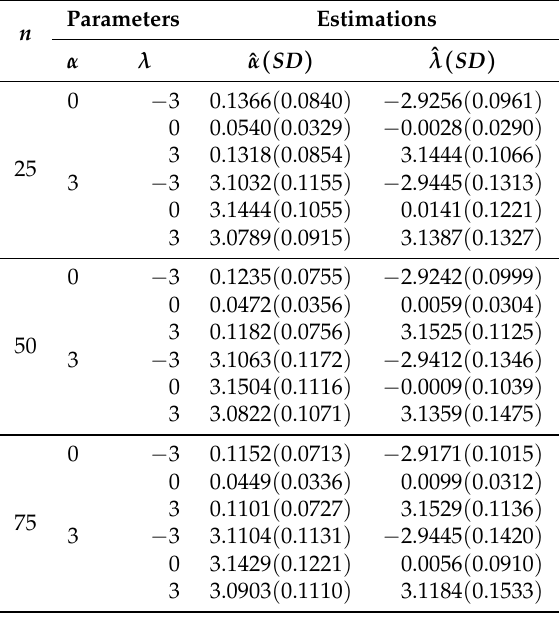
Table 4. Empirical means and standard deviations for ML estimators using Nelder-Mead method (with µ = 0 and σ = 1).